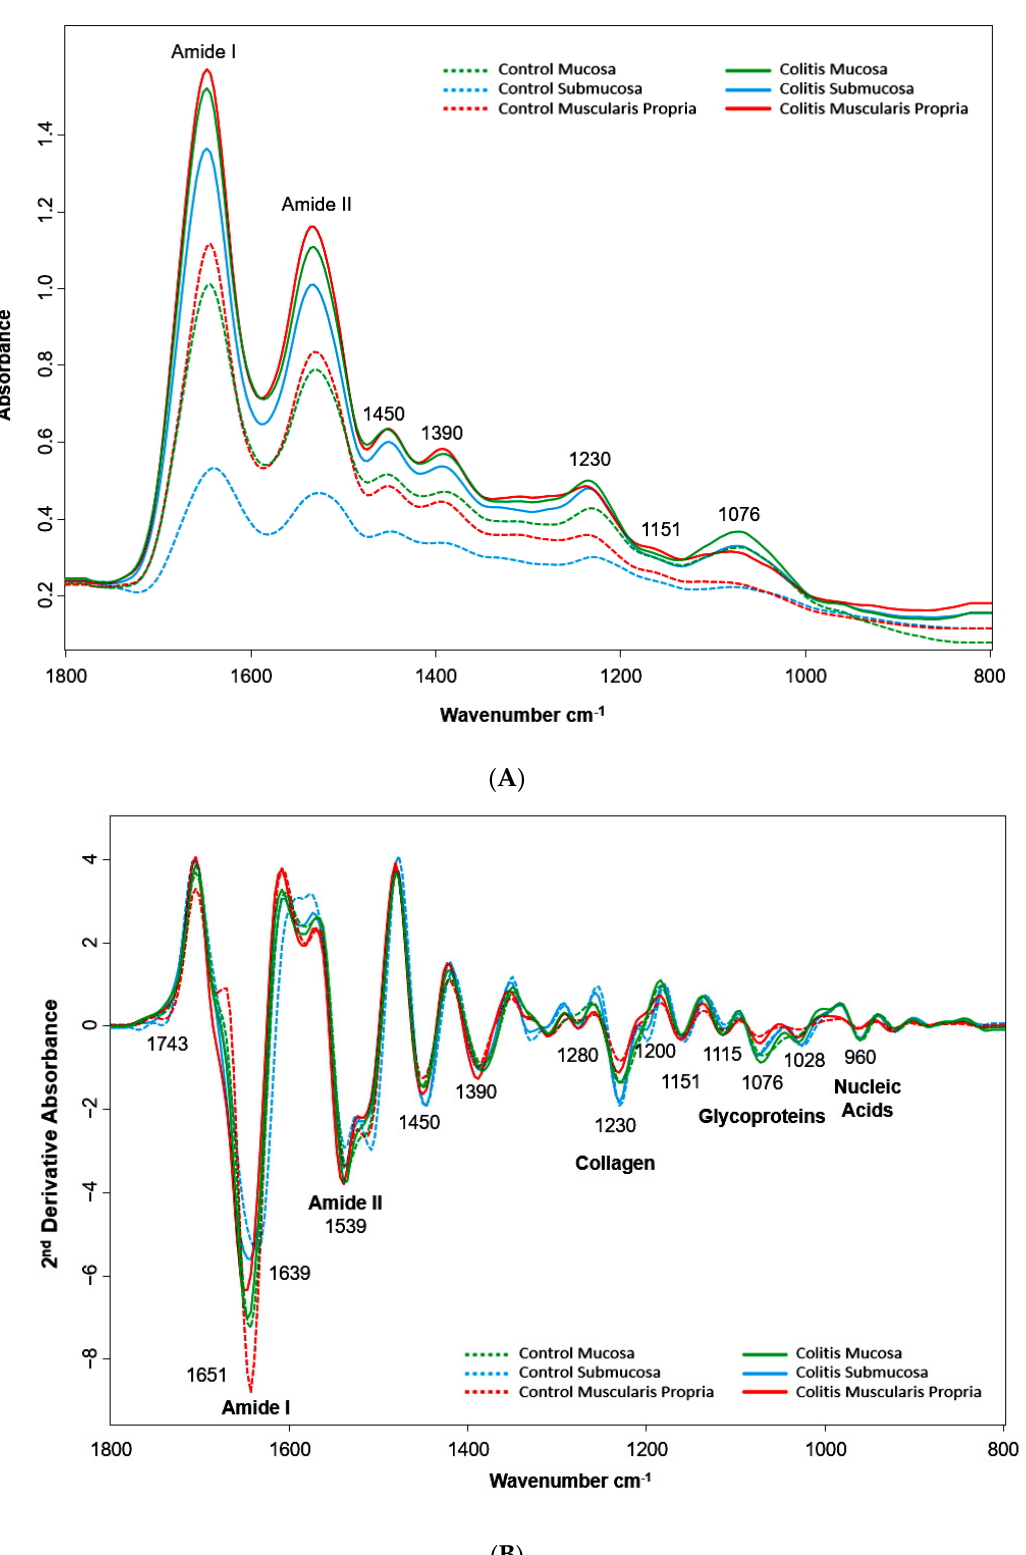
Figure 1. Representation of average spectra obtained from healthy tissue compared with severe colitis. ( A ) Comparison of average original spectra for controls and severe colitis across all layers of the bowel wall. ( B ) Comparison of average second derivative spectra for controls and severe colitis across all layers of the bowel wall.